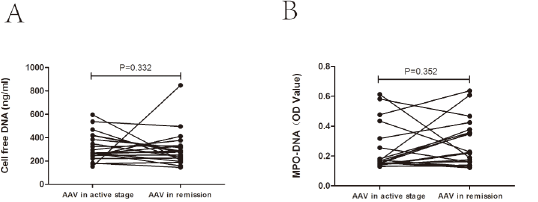
Fig 2. Serum levels of NETs in 20 AAV patients with sequential serum samples. A. Serum levels of cell free DNA. B. Serum levels of MPO-DNA